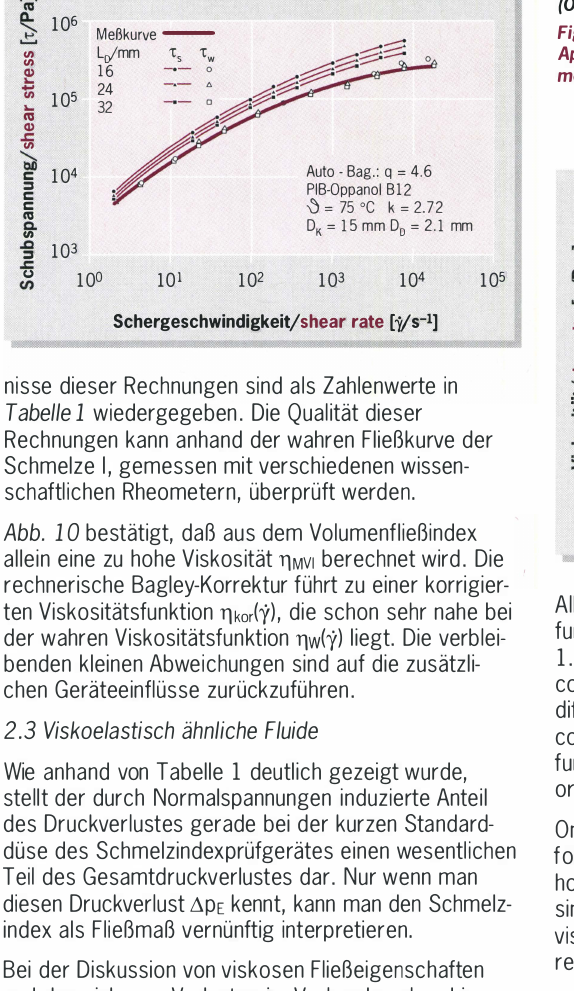
Fig. 9: Apparent shear stress functions of polyisobutylene (Oppanol 812}, measured with capillaries of different length